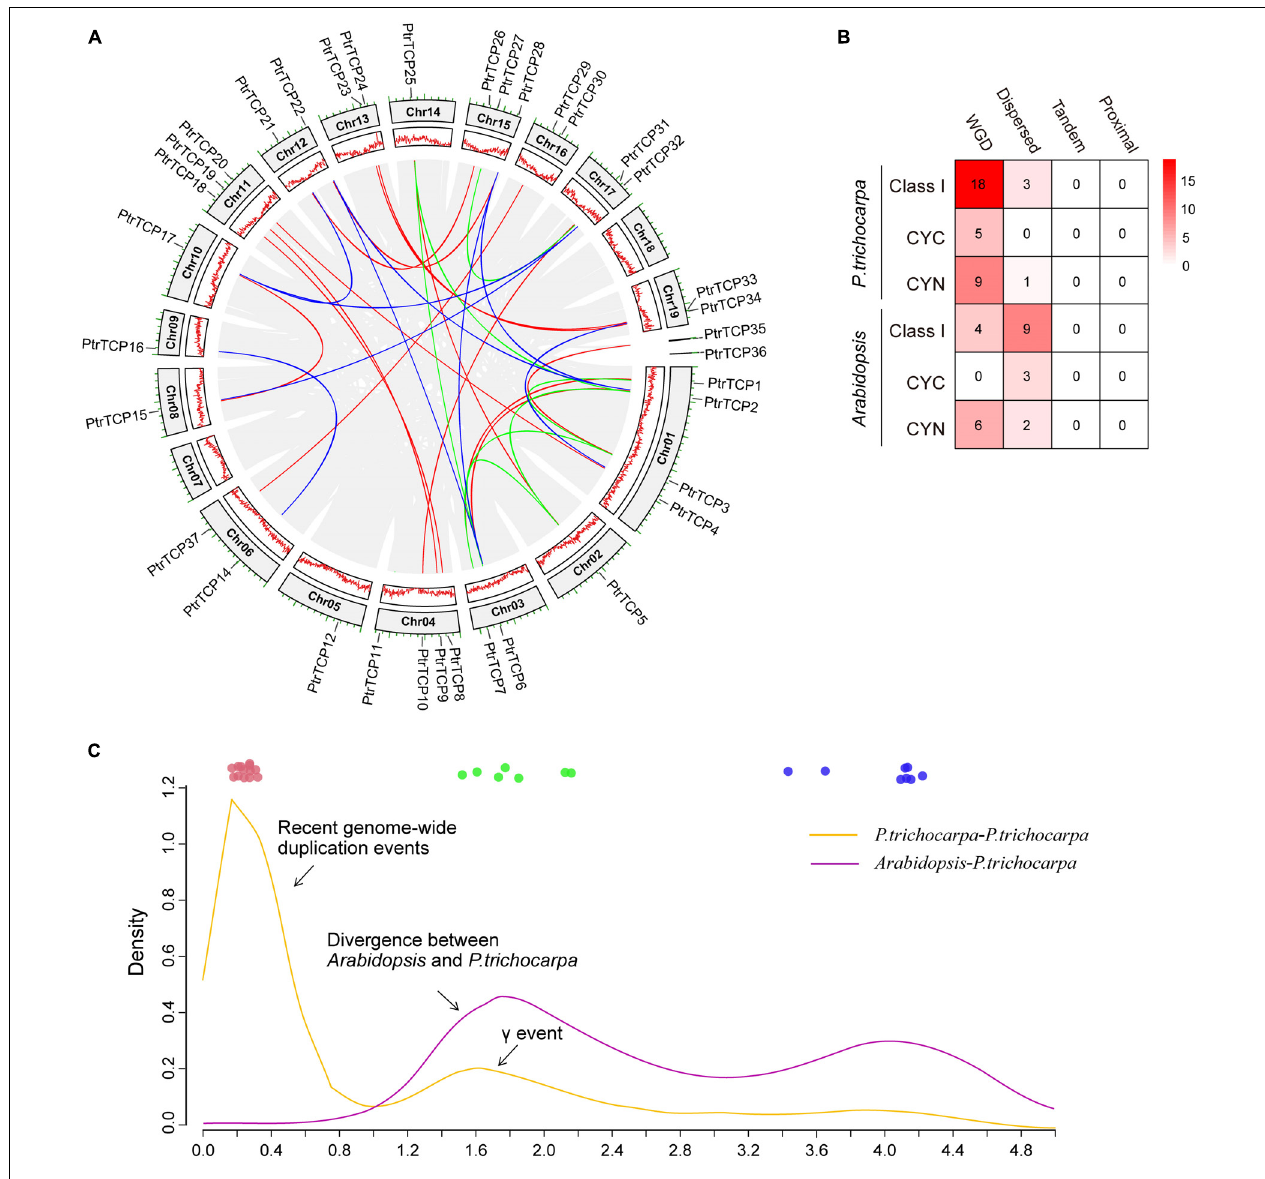
FIGURE 2 | Chromosomal distribution and expansion mechanisms of PtrTCP family genes. (A) Chromosomal distribution and collinear blocks of PtrTCP family genes. The collinear gene pairs of PtrTCP genes are marked with different colors (blue, green, and red) according to the three independent whole genome duplication (WGD) events (ancient WGD, γ -WGT, and rWGD). (B) Comparison of the duplication mechanisms in producing TCP family genes between P. trichocarpa and Arabidopsis . (C) Density distribution of the Ks between all collinear gene blocks within P. trichocarpa and between P. trichocarpa and Arabidopsis . The colored circles indicate the collinear gene blocks containing PtrTCP genes, and they are marked with different colors (blue, green, and red) based on the three main WGD events (ancient WGD, γ -WGT, and rWGD